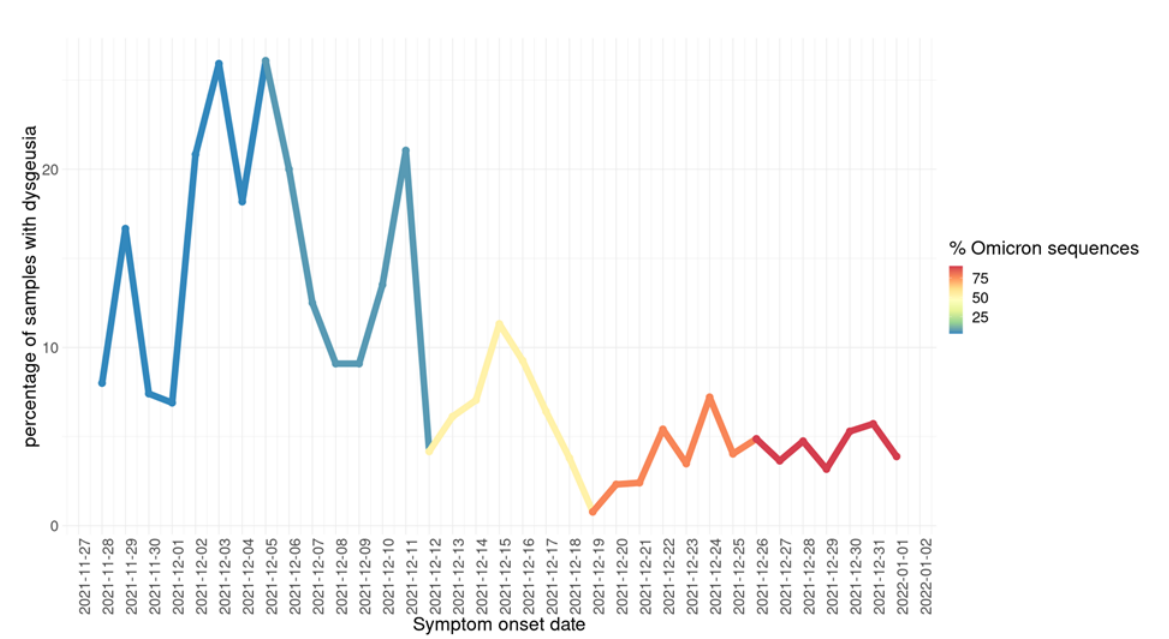
Figure 7. Daily fraction of all COVID-19-positive patients detected in Mexico City who reported dysgeusia as a symptom (by symptom onset date). Line color indicates the (weekly) percentage of sequenced samples identified as Omicron detected by genomic